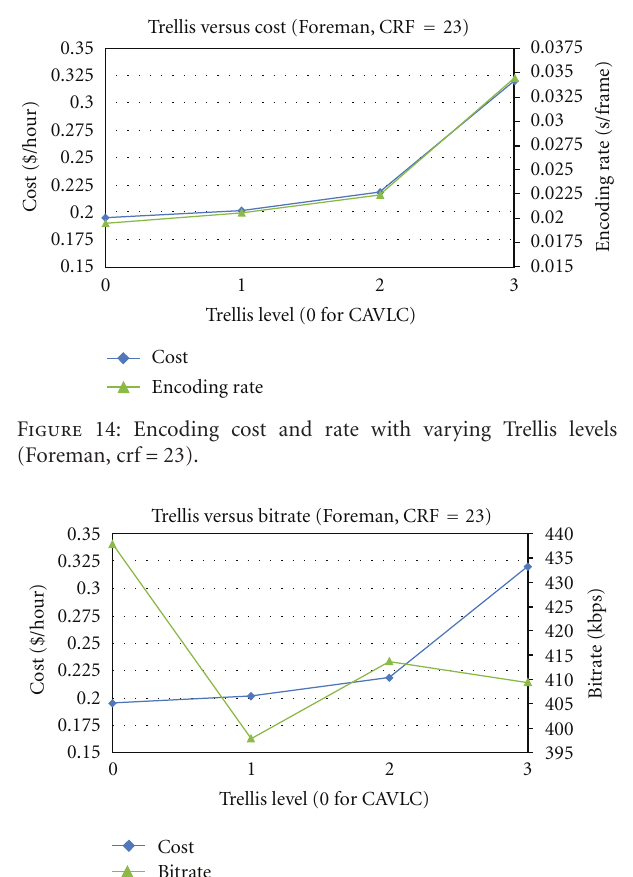
Figure 15: Bitrate and cost with varying Trellis levels (Foreman, crf = 23).